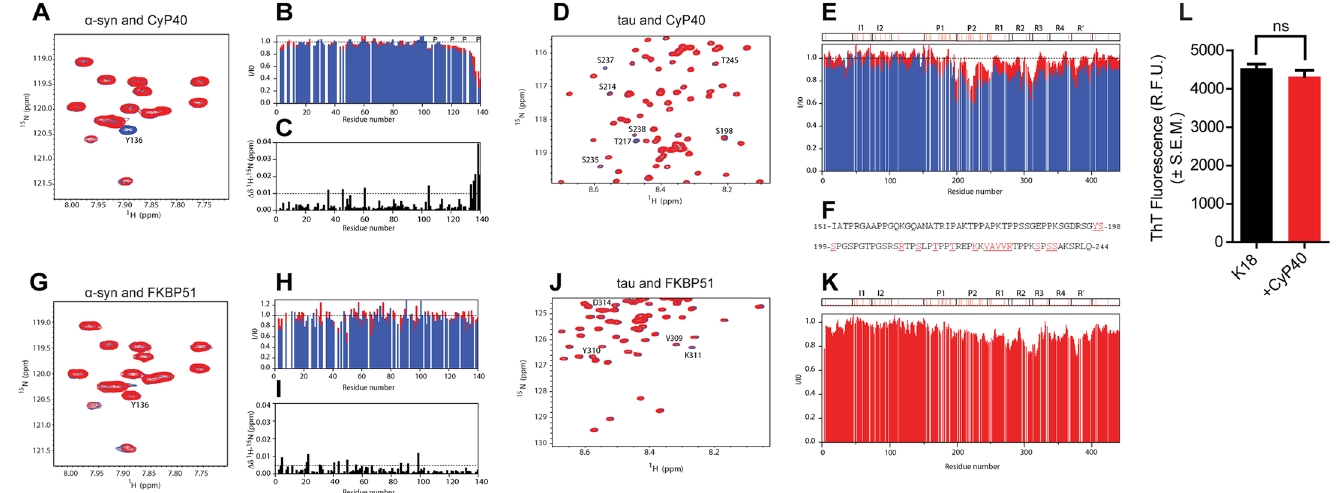
Fig 6. Cyclophilin 40 (CyP40) binds proline-containing regions of tau and α -synuclein ( α -syn). (A) A selectedregionof the 2D [ 1 H- 15 N]– heteronuclear single quantumcoherence (HSQC) experiment of 15 N-labeled α -syn before (blue) and after (red) additionof CyP40 (molar ratio 1:15). Y136 is marked. (B) Normalizedresidue-specific nuclear magneticresonance (NMR) intensities in the presenceof a 5-fold (red) and 15-fold (blue) excess of Cyp40; the location of prolineresidues is indicated. (C) Combined[ 1 H- 15 N] chemical shift perturbationanalysisuponadditionof CyP40 to α -syn. (D) A selectedregionof 2D [ 1 H- 15 N]-HSQC experiment of tau before (blue) and after (red) additionof CyP40 (molar ratio 1:10) is shown. Residuesdisplaying significantintensity loss are labeled.(E) Normalizedresidue-specific NMR intensitiesof tau in the presenceof a 5-fold (red) and 10-fold (blue) excess of CyP40; tau’s domain organization is shown, and proline residues are marked with red. (F) Amino acid sequenceof the proline-rich regions P1 (top) and P2 (bottom); residuessignificantly broadenedupon additionof CyP40 are coloredred. (G) A selectedregionof the 2D [ 1 H- 15 N]-HSQC experiment of 15 N- labeled α -syn before (blue) and after (red) additionof FK-506 bindingprotein (FKBP) 51 (molar ratio 1:10) is displayed. (H) Normalized residue-specific NMR intensities in the presenceof a 5-fold (red) and 10-fold (blue) excess of FKBP51. (I) Combined[ 1 H- 15 N] chemical shift perturbationanalysisupon addition of FKBP51 to α -syn. (J) Selected regionof a 2D [ 1 H- 15 N]-HSQC experiment of tau before (blue) and after (red) additionof FKBP51 (molar ratio 1:10). Final concentrations of CyP40 and FKBP51 for NMR experiments are 200 μ M. (K) Tau residue-specific NMR intensitiesin presence of a 10-fold excess of FKBP51. (L) ThioflavinT fluorescence of K18 tau aggregates in the presenceor absenceof CyP40 (unpaired t test, p > 0.05, n = 3). The numerical data used in panel 6L can be found in S1 Data.